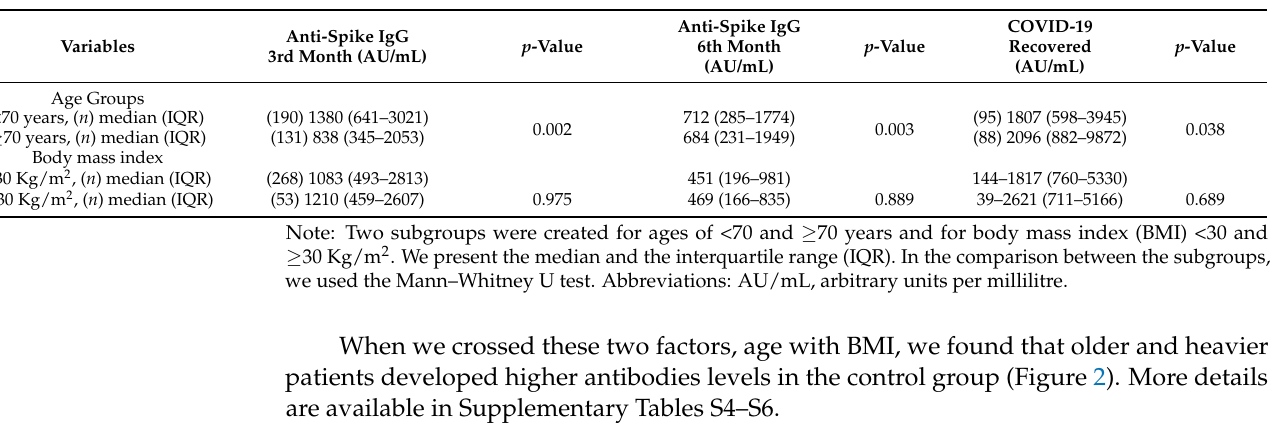
Table 4. Comparison of humoral immunity status in the age and body mass index subgroups.